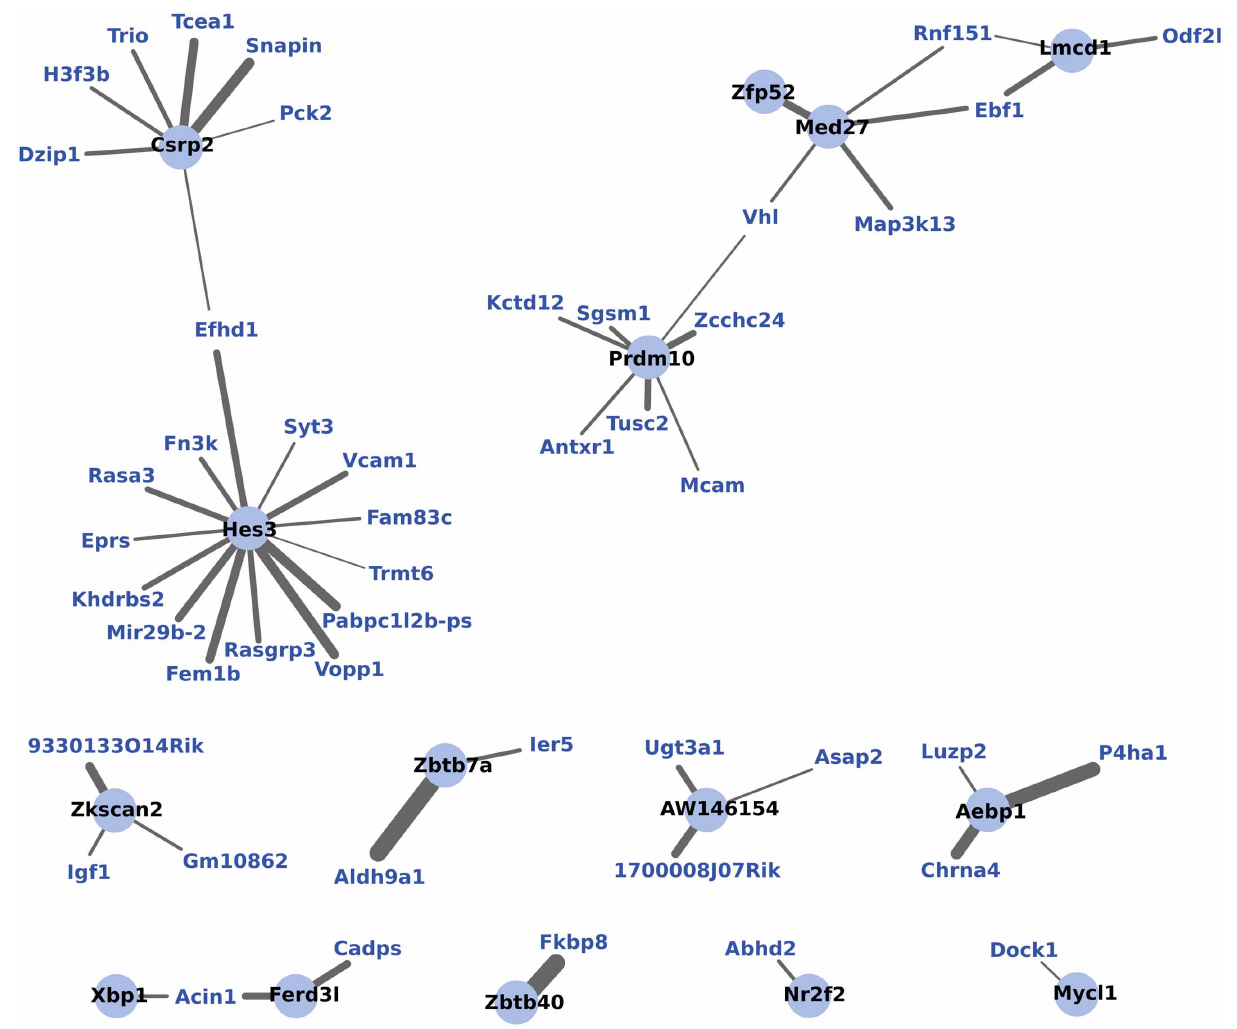
factors (light blue circles with black labels) are visualized in relation to other module genes (blue labels). The significance of the correlation is indicated by the width of the line, with thicker lines reflecting more significant